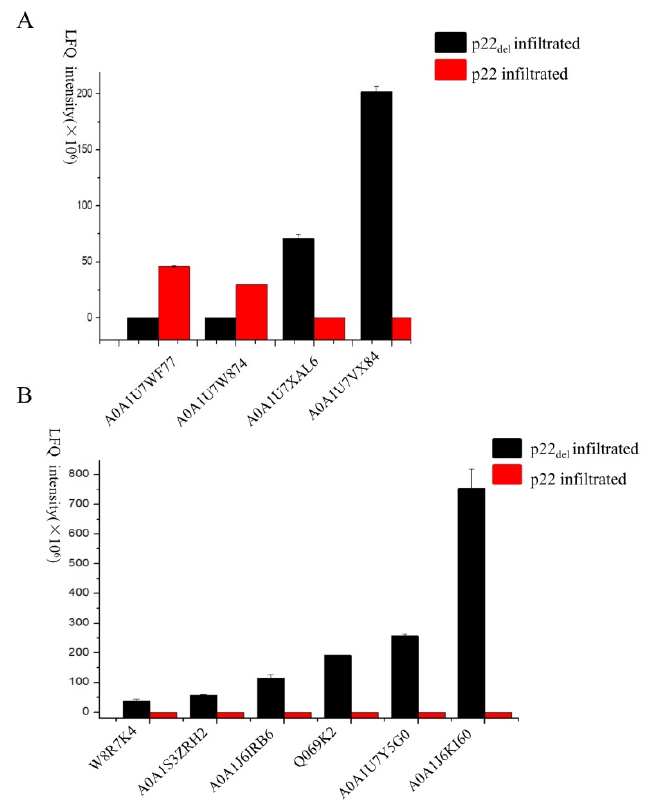
Figure 7. The differential expression of proteins in ubiquitin-mediated proteolysis and cysteine and methionine metabolism. ( A ) Four proteins enriched in the ubiquitin-mediated proteolysis pathway showed differential expression in N . benthamiana leaves expressing p22 and p22 del . LFQ indicates label-free quantitation. The error bars correspond to standard errors. ( B ) Six proteins enriched in the cysteine and methionine metabolism pathway were expressed in p22 del -expressing N . benthamiana leaves, but not in p22-expressing leaves. The error bars correspond to standard errors.